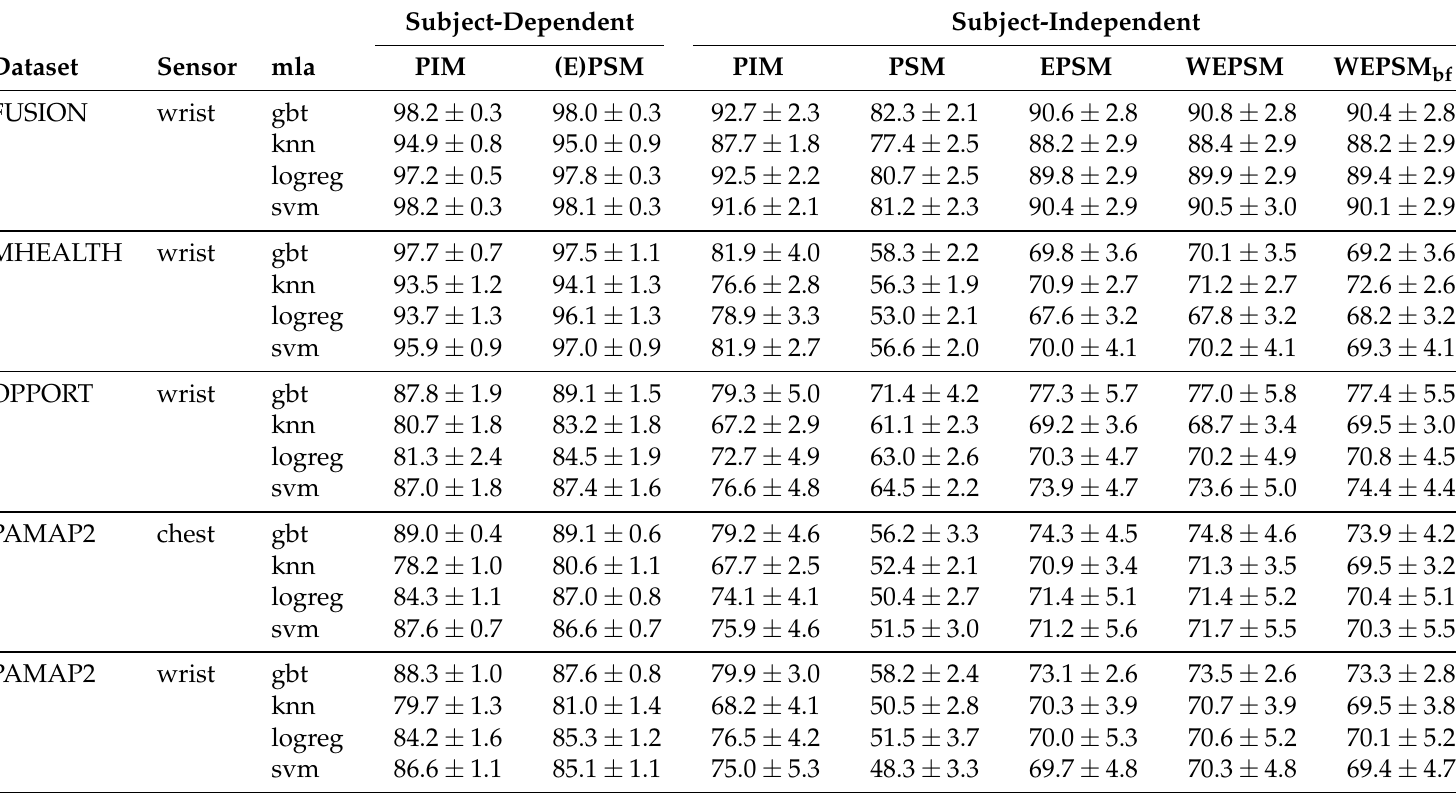
Table A3. Weighted subject-dependent and subject-independent F-score (%) ± standard error when learning algorithms (mla) are combined with a person-independent model (PIM), a person-specific model (PSM), an unweighted ensemble of PSMs (EPSM), a κ -weighted EPSM (WEPSM), or a baseline-feature-weighted EPSM (WEPSM bf